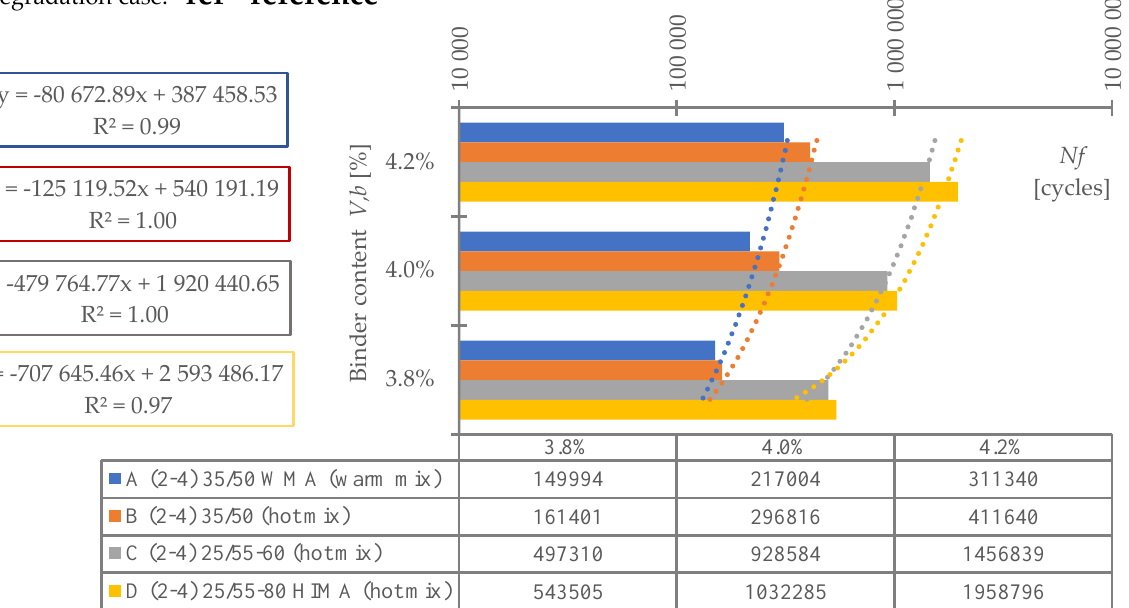
Figure 8. Fatigue test results — reference set.